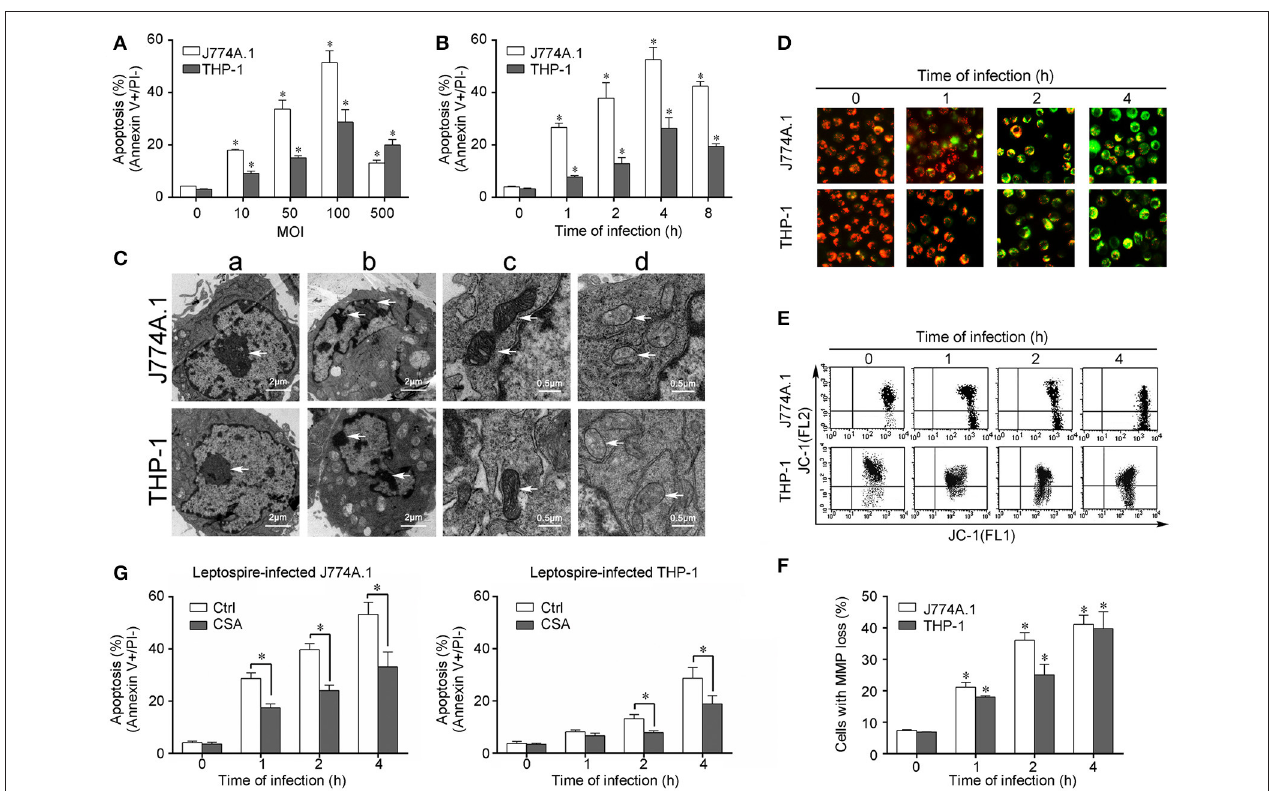
FIGURE 1 | Apoptosis, pathological changes, and MMP decrease in leptospire-infected macrophages. (A) Apoptosis of macrophages infected with L. interrogans strain Lai at the optimal apoptosis-causing time for different MOIs. J774A.1 and THP-1 cells were infected with leptospires at 4h. Bars show the mean ± SD of three independent experiments. Five thousand cells were analyzed in each specimen. * p < 0.05 vs. apoptotic ratios in leptospire-infected macrophages with an MOI of 10, 50, 100, or 500. (B) Apoptosis of macrophages infected with L. interrogans strain Lai at the optimal apoptosis-causing MOI for different times. J774A.1 and